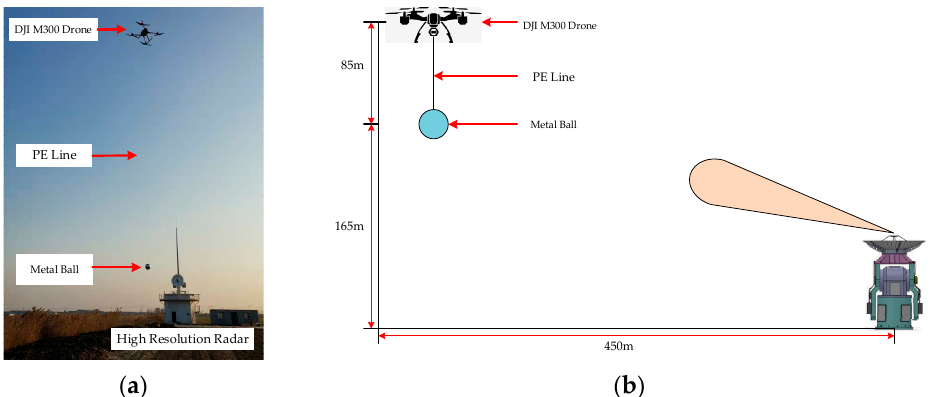
Figure 14. Metal ball observation experiment scenario: ( a ) photo; ( b ) schematic diagram.